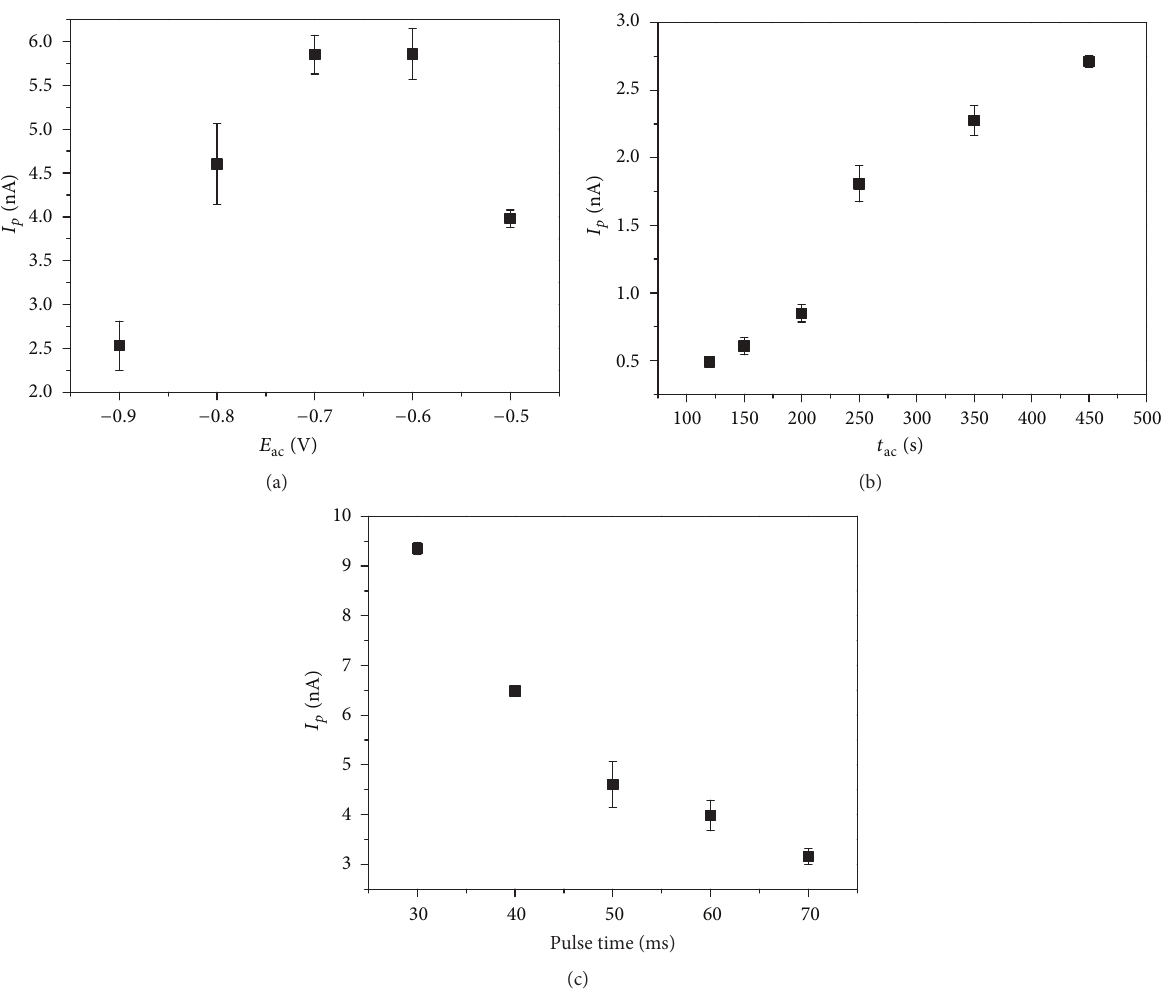
Figure 3: Optimization of the voltammetric parameters for the determination of EE2 (20.0 𝜇 g L −1 ) by DP AdCSV. (a) Effect of accumulation potential with scan rate: 90 mVs −1 , equilibrium time: 5s; 𝑡 time with scan rate: 60 mVs −1 ; equilibrium time: 5 s; pulse amplitude: 50 mV; pulse time: 40ms; and 𝐸 scan rate: 60 mVs −1 ; equilibrium time: 5 s; 𝑡